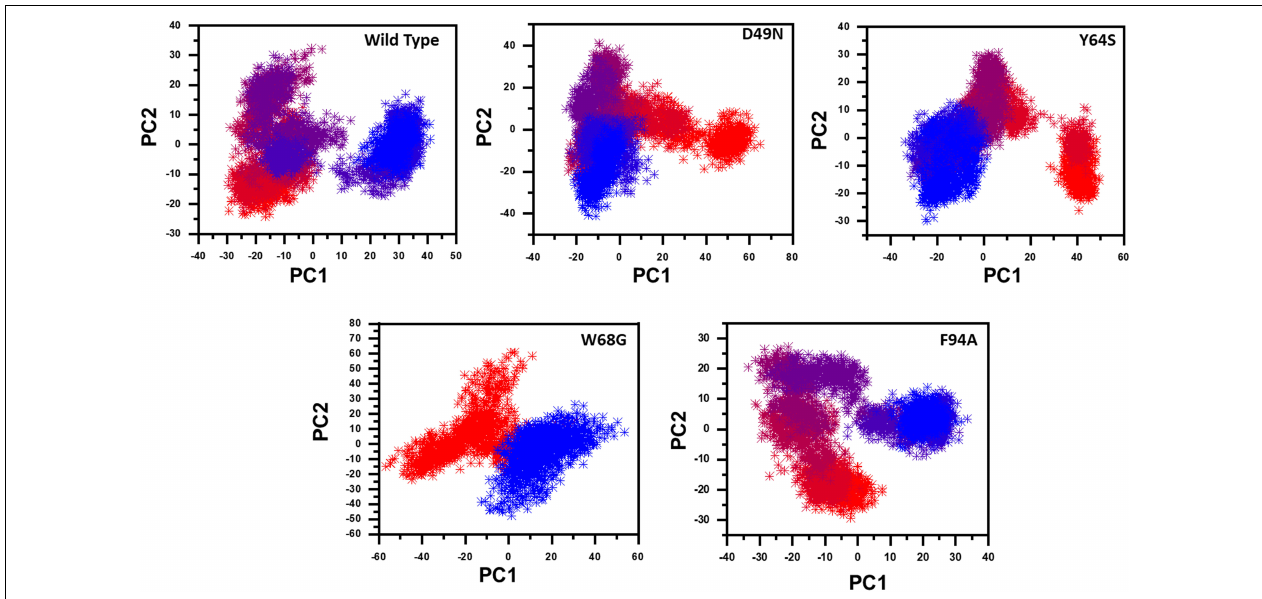
FIGURE 6 | Principal component analysis of all systems, including the Wild type and the four mutants. The first two principal components (PC1 and PC2) are used to project motion in the space phase at 300 K.